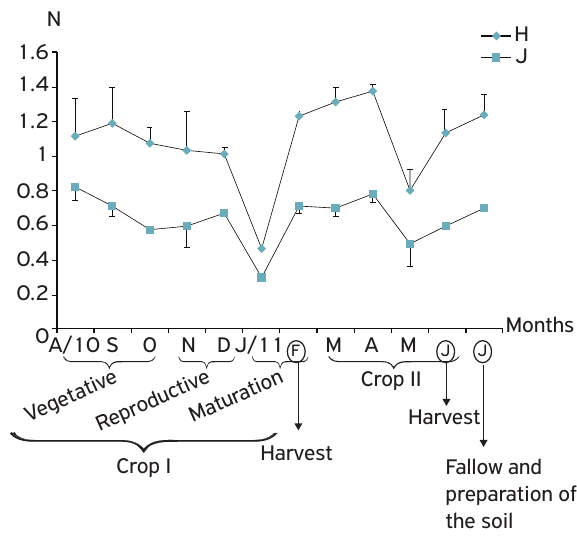
Figure 3. Monthly (August to July) mean fluctuation of diversity (H’) and evenness (J) of granivorous birds in the irrigated rice